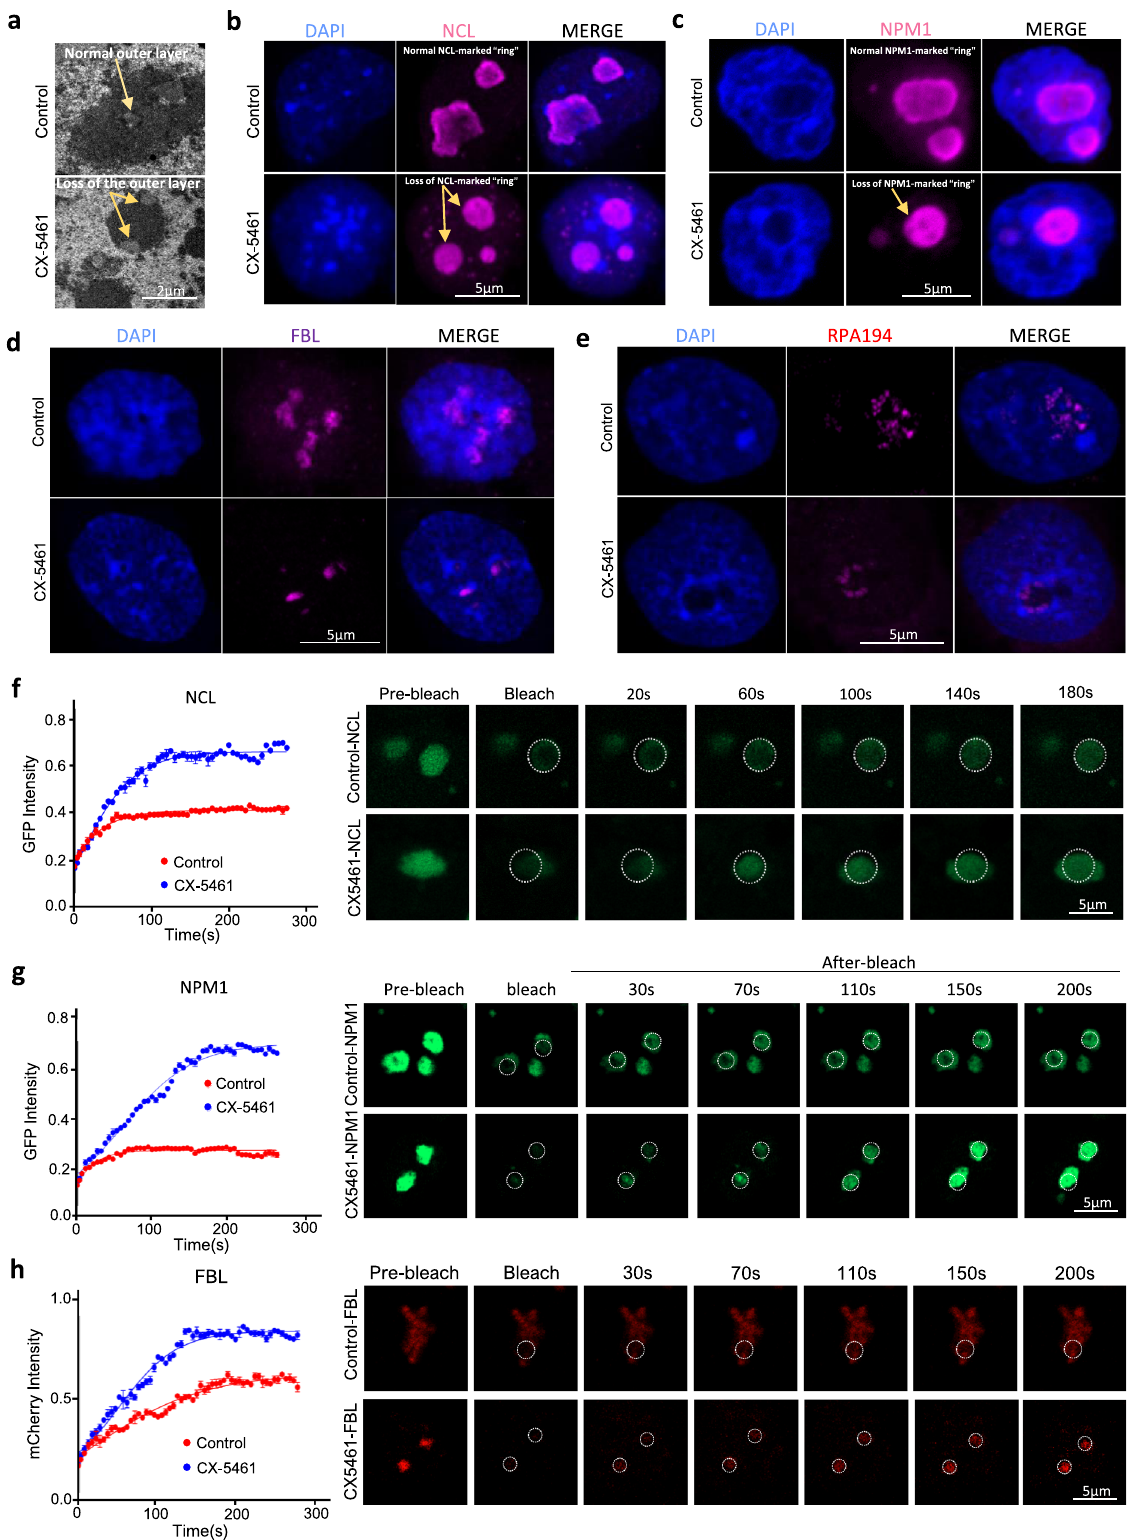
with control cells (Fig. 8k, l and Supplementary Fig. S8g, h). Col- lectively, these results further con fi rmed that repressing rRNA bio- genesis can activate 2C-like program and induce the transition of mES cells to 2C-like